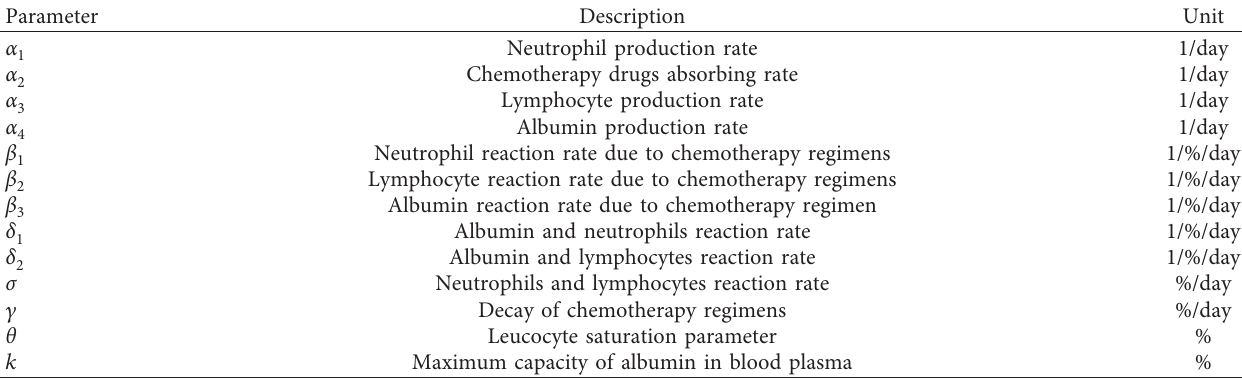
Table 1: Parameters description.